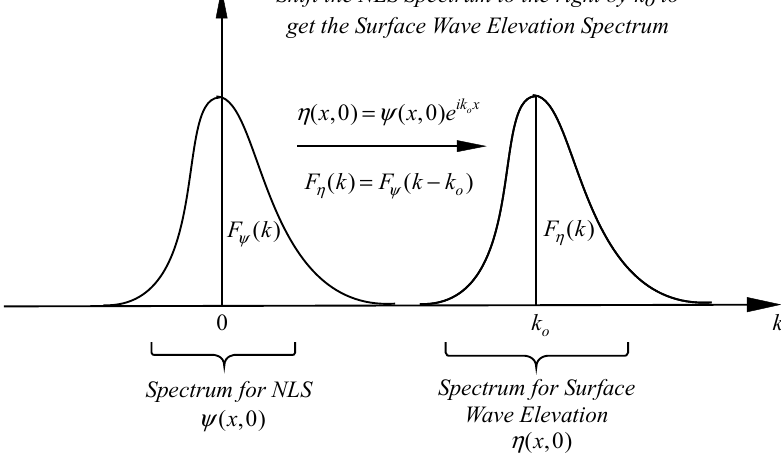
Figure 1. Complex modulation Fourier spectrum for the nonlinear Schrödinger (NLS) equation in wavenumber space (left, centered about zero wave number) and the surface wave elevation spectrum (right, centered about k o ). The example shown is intended to represent the case of an ocean wave Fourier spectrum such as that of Pierson-Moskowitz or JONSWAP (Joint North Sea Wave Project [14]). The surface wave spectrum is obtained from the NLS spectrum by shifting the NLS spectrum to the right by k o (see Equation (14)). We call k o the carrier wavenumber.